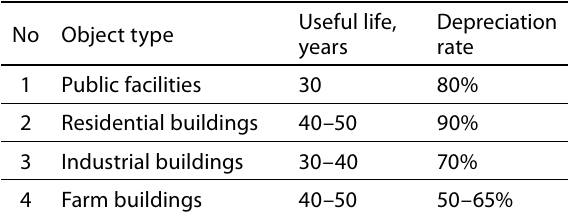
Table 2. Statictical characteristic of the obsolescence